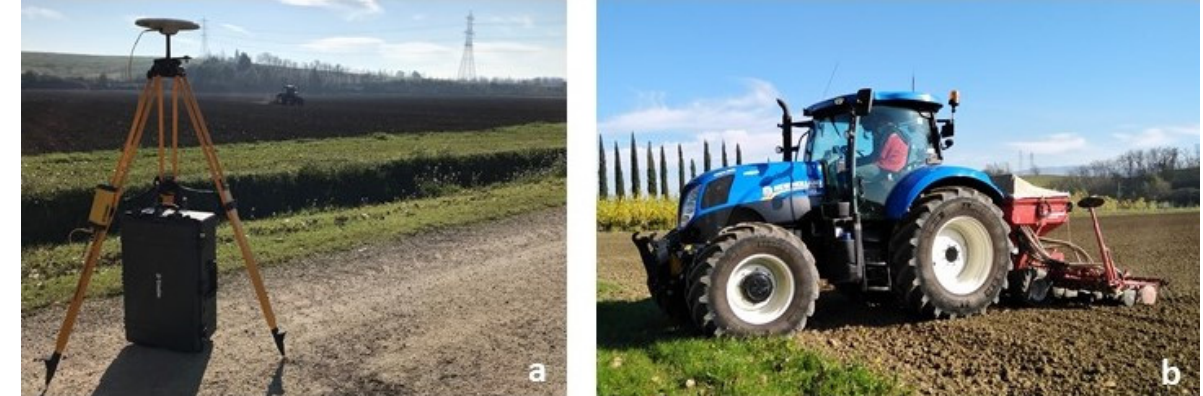
Figure 1. ( a ) RTK Base Station; ( b ) Tractor with technology IntelliSteer equipped with a pneumatic